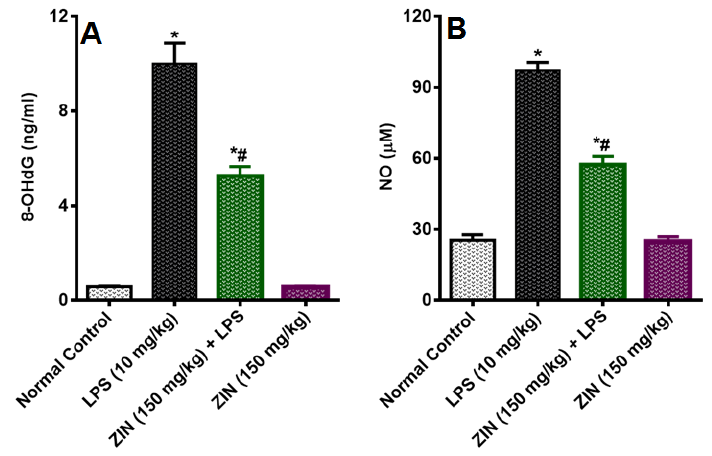
Figure 3. E ff ect of zingerone (ZIN) on LPS-induced DNA damage and oxidative stress marker. Figure 3. Effect of zingerone (ZIN) on LPS-induced DNA damage and oxidative stress marker. ( A ) ( A ) 8-OHdG levels (ng / mL), ( B ) Nitric Oxide (NO) levels ( µ M). Results are represented as mean ± SEM 8-OHdG levels (ng/mL), ( B ) Nitric Oxide (NO) levels (µM). Results are represented as mean ± SEM of of six rats / group. * p < 0.05 vs. control; # p < 0.05 vs. LPS six rats/group. * p < 0.05 vs. control; # p < 0.05 vs. LPS group.